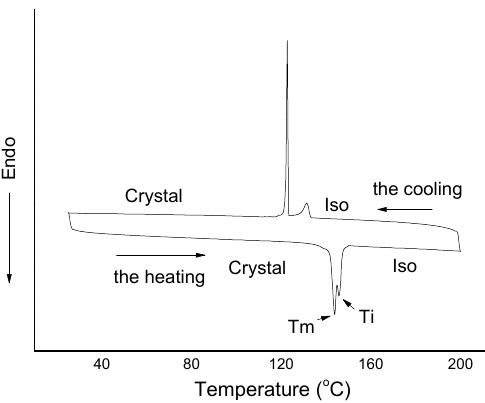
Figure 5. DSC thermograms of C4-Azo-C5-HDA.